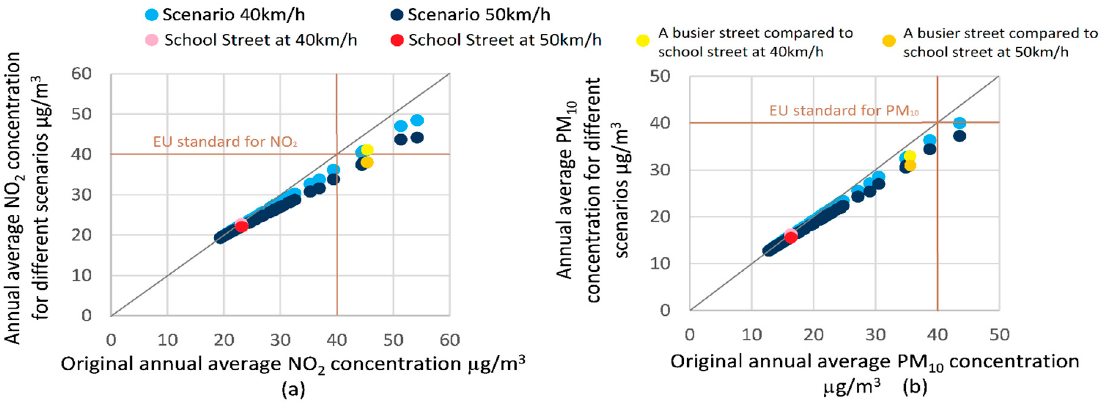
Figure 5. Predicted change in ( a ) NO 2 and ( b ) PM 10 total street concentrations on each road segment in the model domain for varying speed limits.